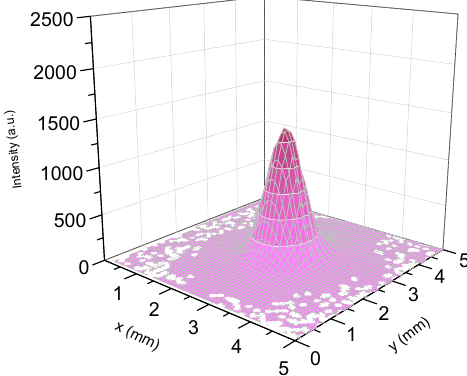
Figure 3. Far field spatial intensity distribution of the λ measured under the experimental configuration of Figure 2(b) without any optics between the laser and the detector